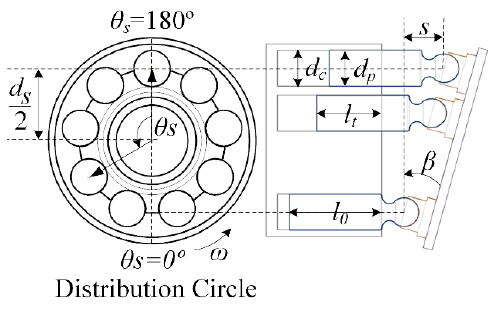
Figure 4. Definitions used for mechanical analysis.